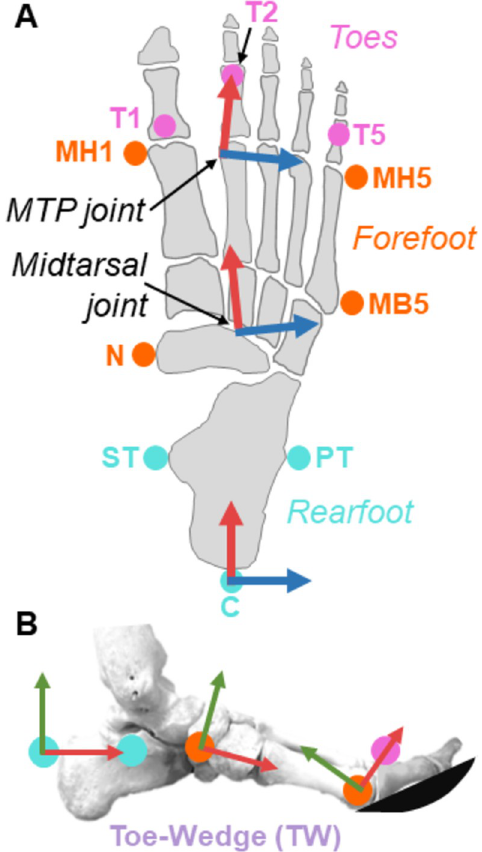
Fig 2. Multi-segment foot model. (A) Dorsal view of markers used to define the rearfoot (light blue; C = calcaneus, ST = sustentaculum tali, PT = peroneal tubercle), forefoot (orange; N = navicular, MH1 = metatarsal head 1, MH5 = metatarsal head 5, MB5 = metatarsal base 5), and toe (pink; T1, T2, and T5 = toe 1, toe 2, and toe 5, respectively) segments. Red arrows indicate the x-axis of the respective segment and blue arrows indicate the z-axis. (B) Medial view of markers defining foot segments. Red arrows indicate the segment’s x-axis and green arrows indicate a segment’s y-axis. The toe-wedge condition is depicted here wherein participants walked with a rounded toe-wedge which dorsiflexed their MTP